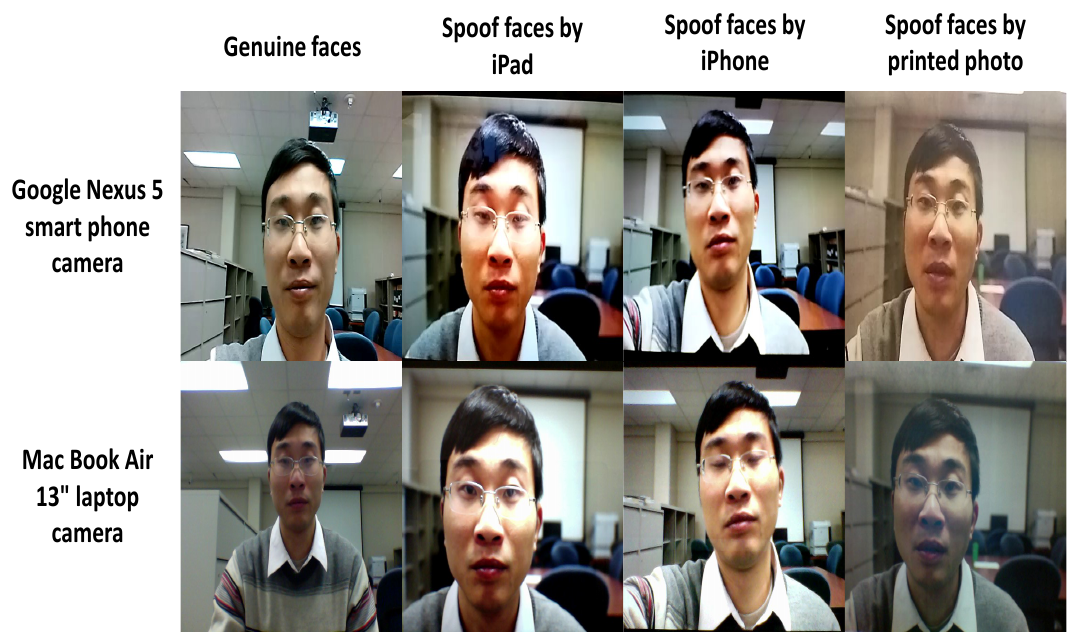
Figure 5. Example images of genuine and attack presentation of one of the subjects in the MSU- MFSD